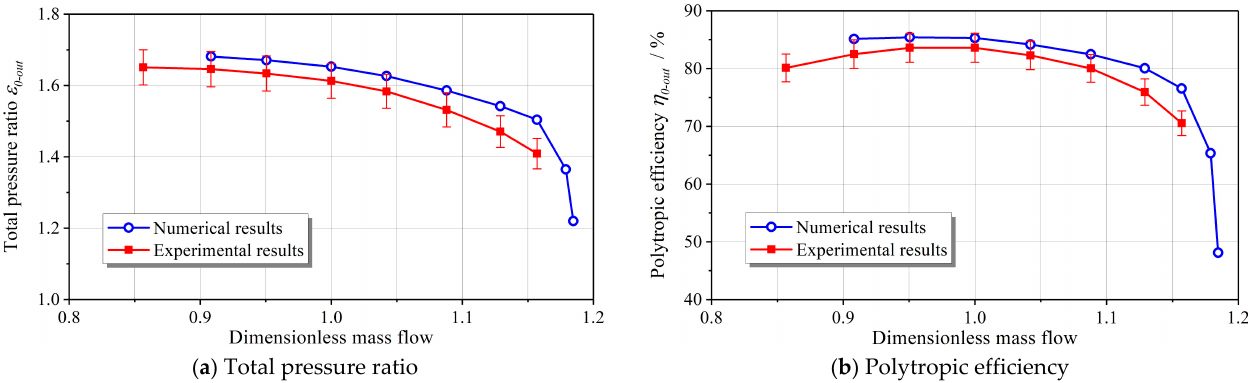
Figure 7. Comparison of the numerical and experimental performances for the compressor stage .